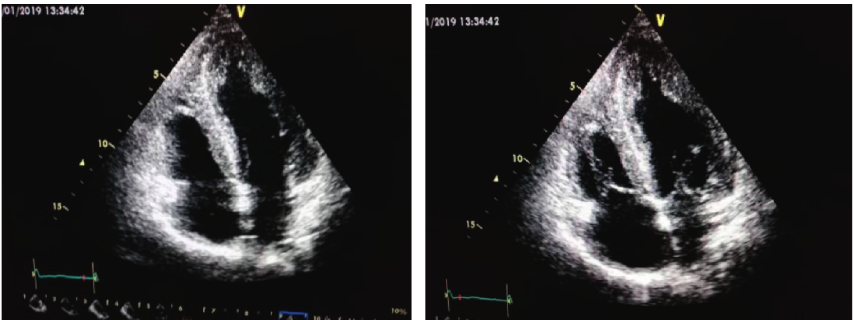
Figure 2: Echocardiogram photographs show granular sparkling of the myocardium walls suggesting cardiac amyloidosis.